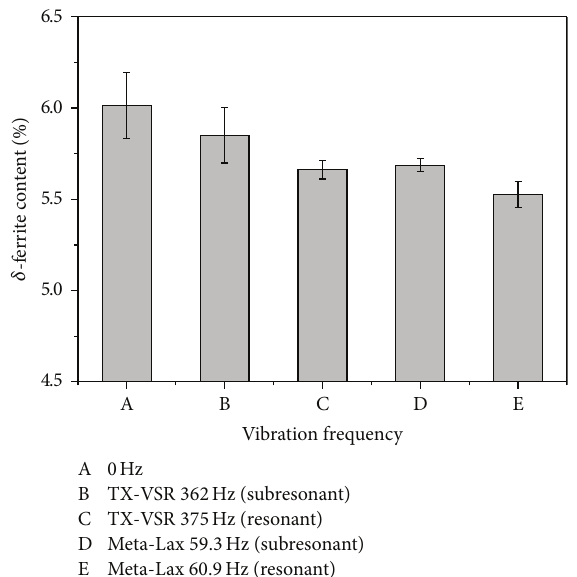
Figure 15: The relationship between the vibration frequency and the hardness